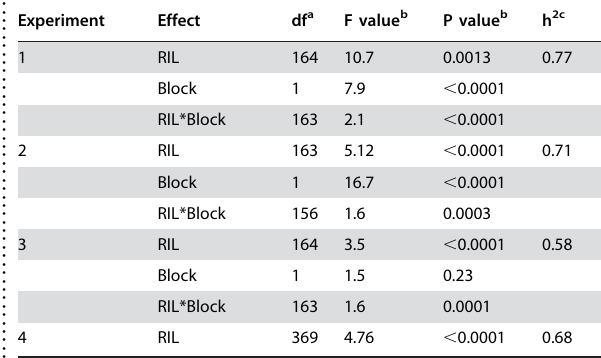
Table 1. The influence of genotype on partial resistance